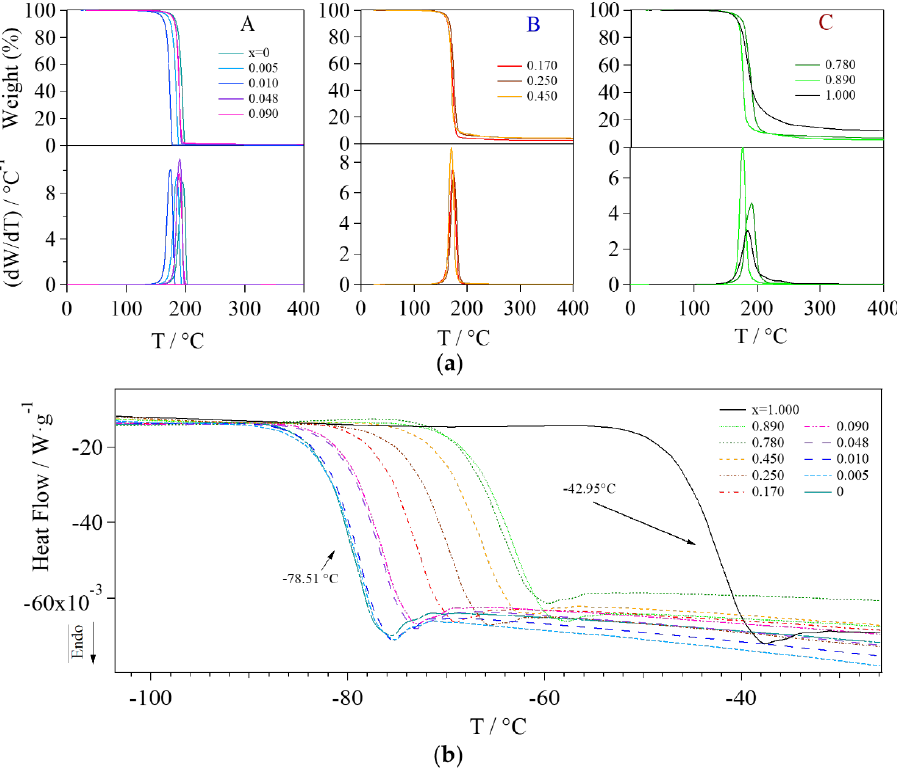
Figure 7. ( a ) Thermo-gravimetric analyses of GlyLi x . ( b ) MDSC profiles of GlyLi x .